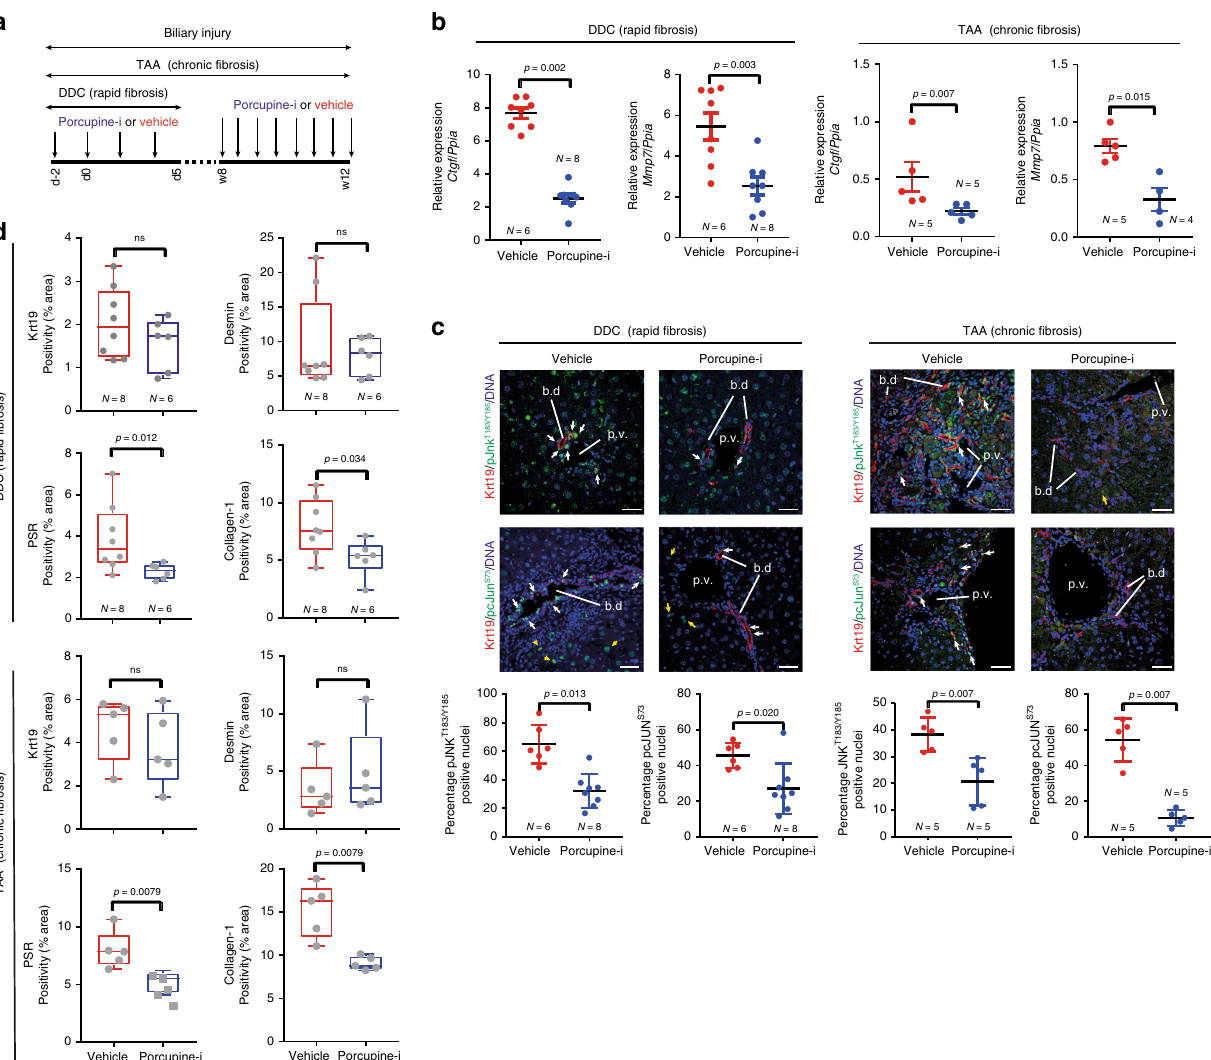
Fig. 2 Therapeutic inhibition of Wnt reduces scarring. a Schematic of Porcupine inhibition with Porcupine-i during bile duct regeneration induced by DDC or TAA. b mRNA expression of Wnt-PCP pathway target genes Ctgf and Mmp7 in isolated bile ducts following Porcupine-i treatment, normalised to the housekeeping gene Ppia . c Immuno fl uorescent staining of biliary epithelial cells (Keratin-19-positive, red) with phosphorylated JNK T183/Y185 (upper panels) or phosphorylated c-JUN S73 (lower panels), green. White arrows denote positivity in biliary epithelial cells, yellow arrows show positivity in other, non- keratin-19-positive cells. Positivity of phosphorylated JNK T183/Y185 and phosphorylated c-JUN S73 quanti fi ed in dot plots and represented as a proportion of total biliary epithelial cells counted. d Histological quanti fi cation of Keratin-19 (biliary epithelial cells), Desmin ( fi broblasts), Picrosirius Red, PSR ( fi brilar collagens) and Collagen-1 in livers of mice treated with either DDC or TAA, following Porcupine inhibition. Scale bar = 50 µ m. p.v. — portal vein, b.d. — bile duct. Source data are provided as a Source Data fi le. In all comparisons, a Student ’ s t test is used. Box – whisker plots represent min – max range of the data. In dot plots, data are presented as mean ± S.E.M. Each data point (N) represents an individual